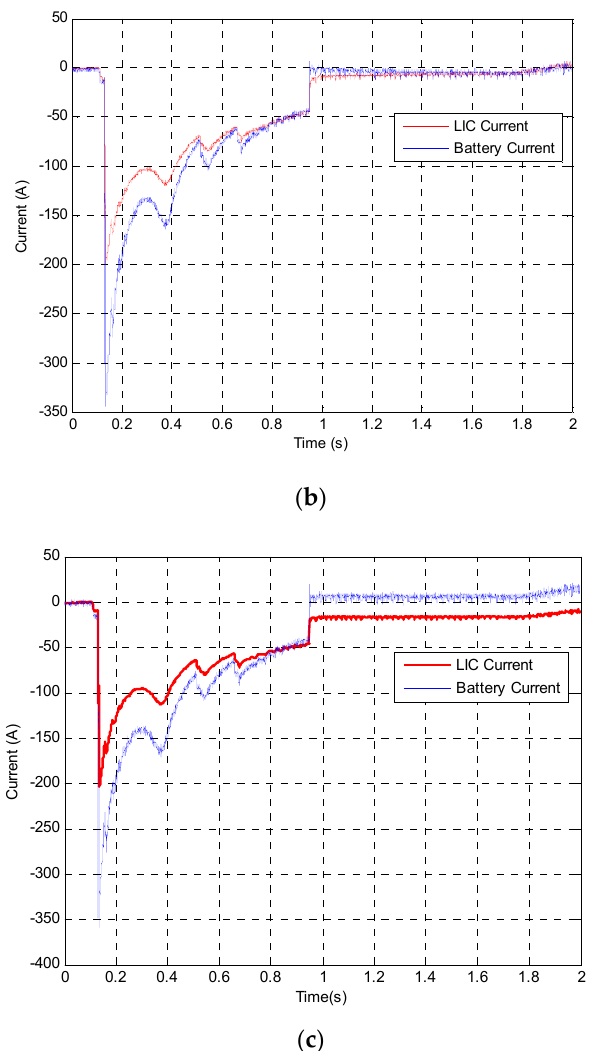
Figure 6. Battery-biased parallel connection: ( a ) connection diagram; ( b ) test results; ( c ) simulation results.